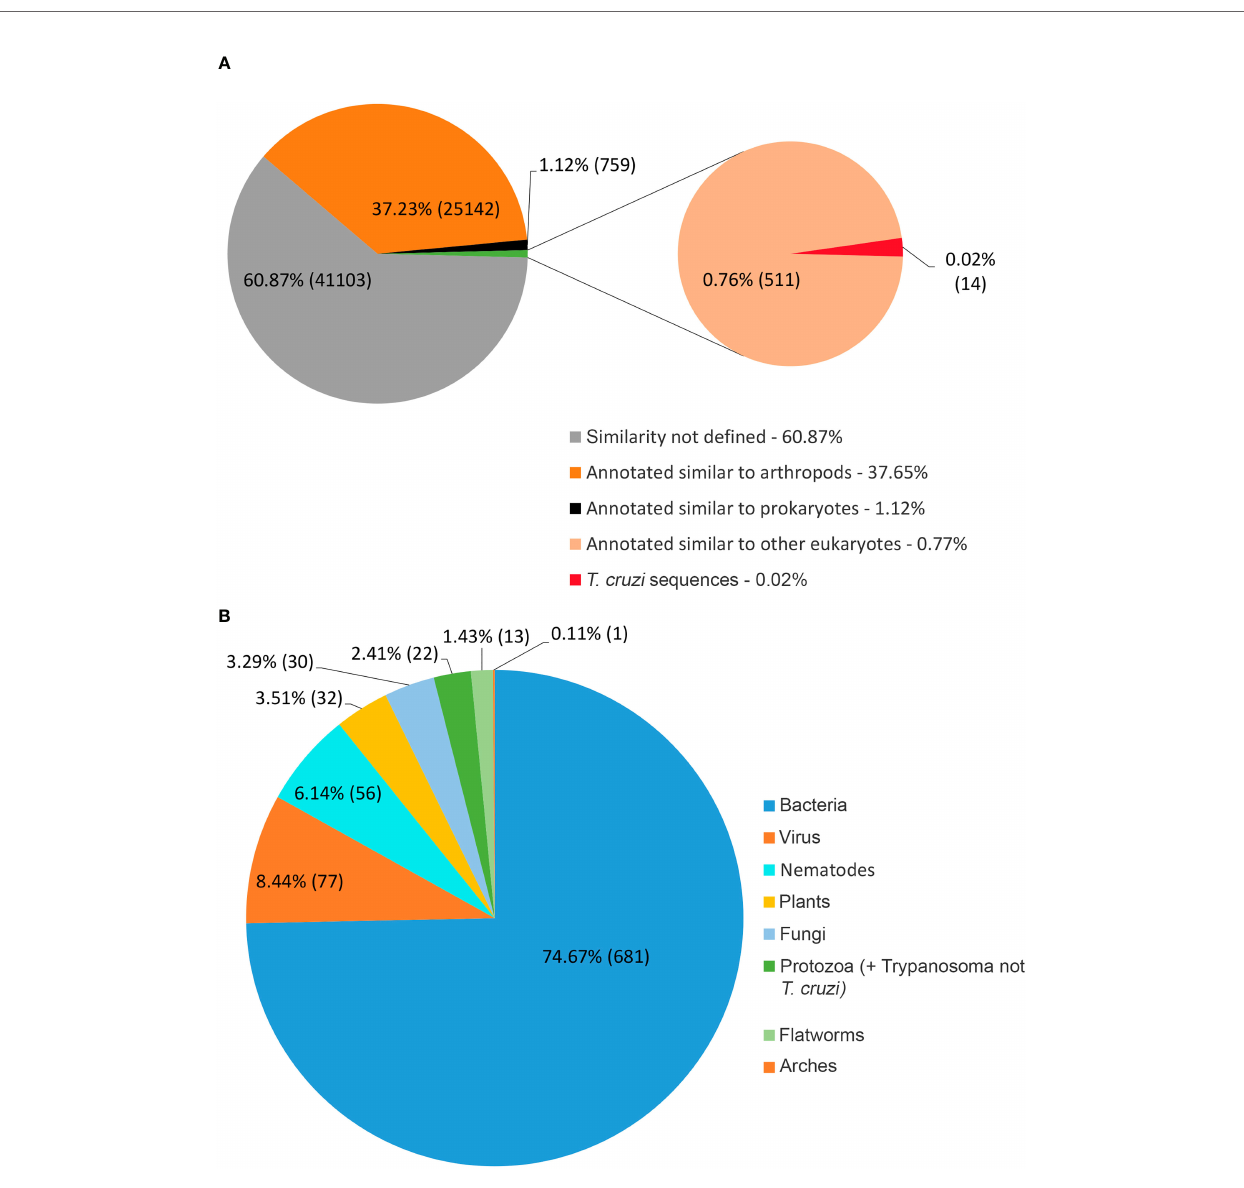
FIGURE 2 | Distribution of transcripts according to annotated taxonomic similarity. (A) Annotated distribution of transcripts generated by pairing against sequences from public databases, highlighting arthropod annotations and those not taxonomically de fi ned, constituted by new transcripts identi fi ed by the multi k-mer methodology. (B) Annotated found that resemble symbiont/residual proteins. The most signi fi cant transcripts are similar to bacterial proteins (74.7%), consistent with the salivary gland and intestine fi